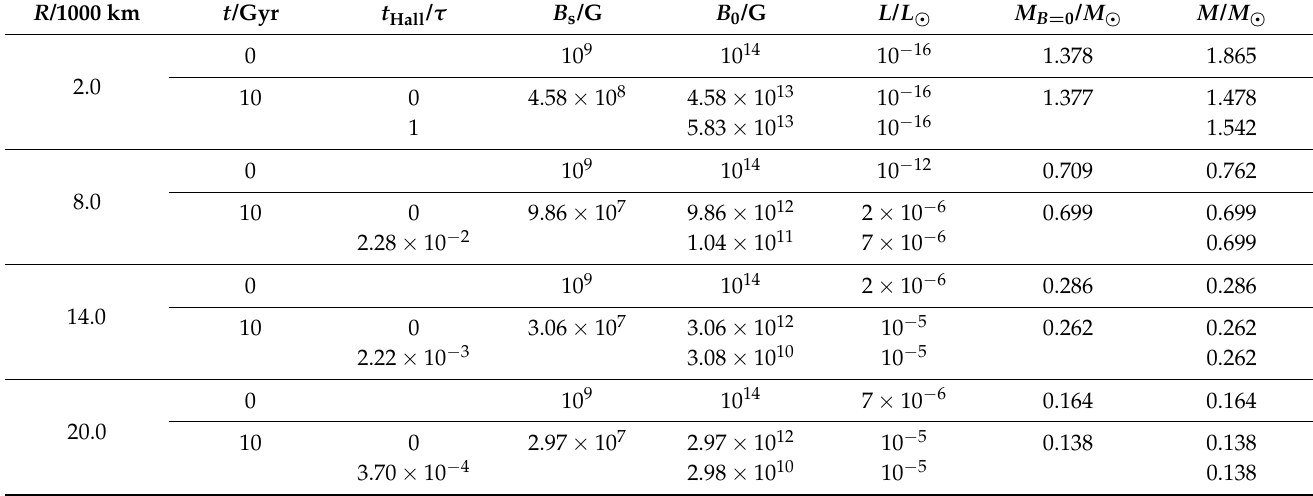
Table 1. The effect of magnetic field on luminosity when the initial field is fixed at B = ( 10 9 ,10 14 ) G for all the radii. The topmost entry for each radius is the initial time, whereas the bottom two entries list corresponding parameters for t = τ = 10 Gyr. We evaluate fields assuming Ohmic dissipation is the dominant process for the top entries of τ = 10 Gyr, and for the bottom entries, we assume Hall drift is the primary process until the field parameter B 0 decays to ∼ 10 12 G, below which Ohmic dissipation